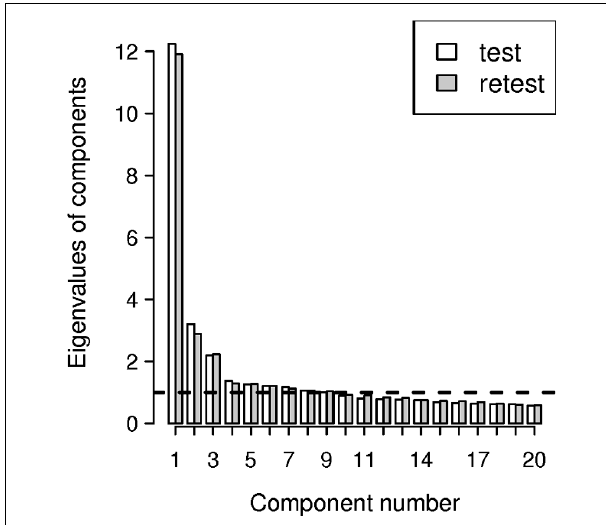
FIGURE 1 |The scree plot of the exploratory factor analysis of the In-Out DispositionalAffective Style Questionnaire (IN-OUT DASQ) item pool. The number of factors is determined by examining until the slope of the graph changes from rapid to slow decline.The scree plot suggests a three factor solution: one “method” factor and two “latent trait” factors.